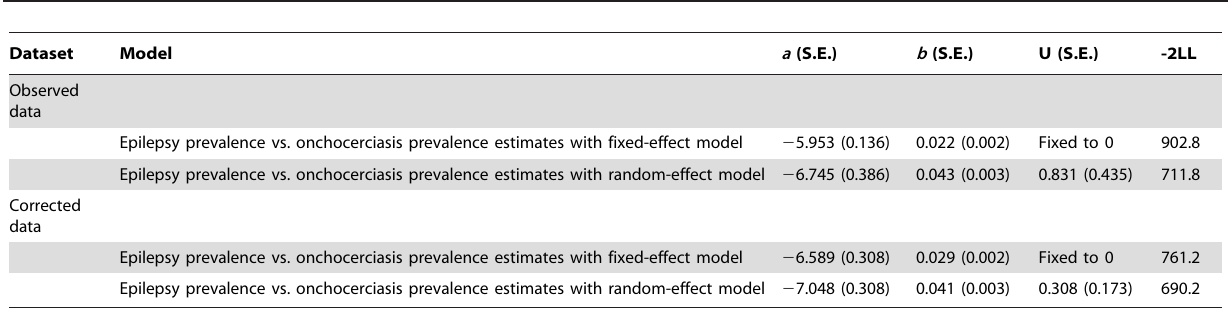
Table 3. Parameters estimated (and standard errors) from logistic regression of epilepsy (y) on onchocerciasis (x) prevalences.